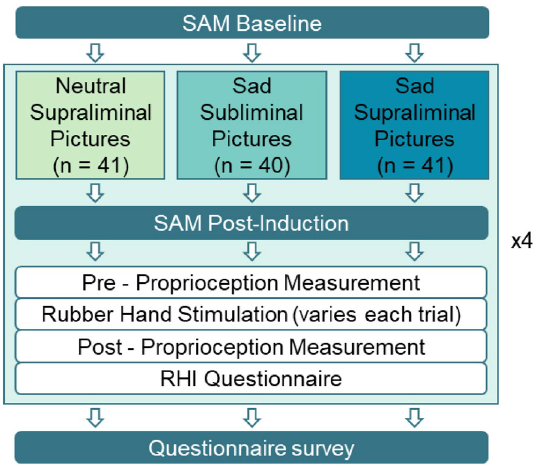
Figure 8. Experimental procedure. The tasks displayed in the light blue box were repeated four times, each time with a different stroking condition (e.g. asynchronous × slow